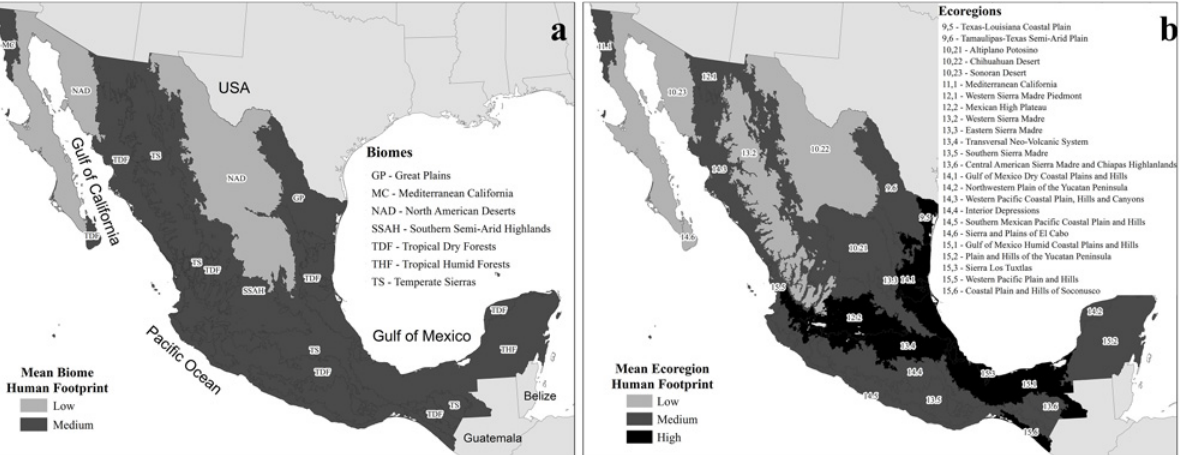
Fig 2. Mean footprint in large regions. Biomes (a) and ecoregions (b) of Mexico grouped into categories defined by their mean human footprint (low, medium, and high human footprint, with mean HF < 1; 1 < HF < 3, and HF > 3,